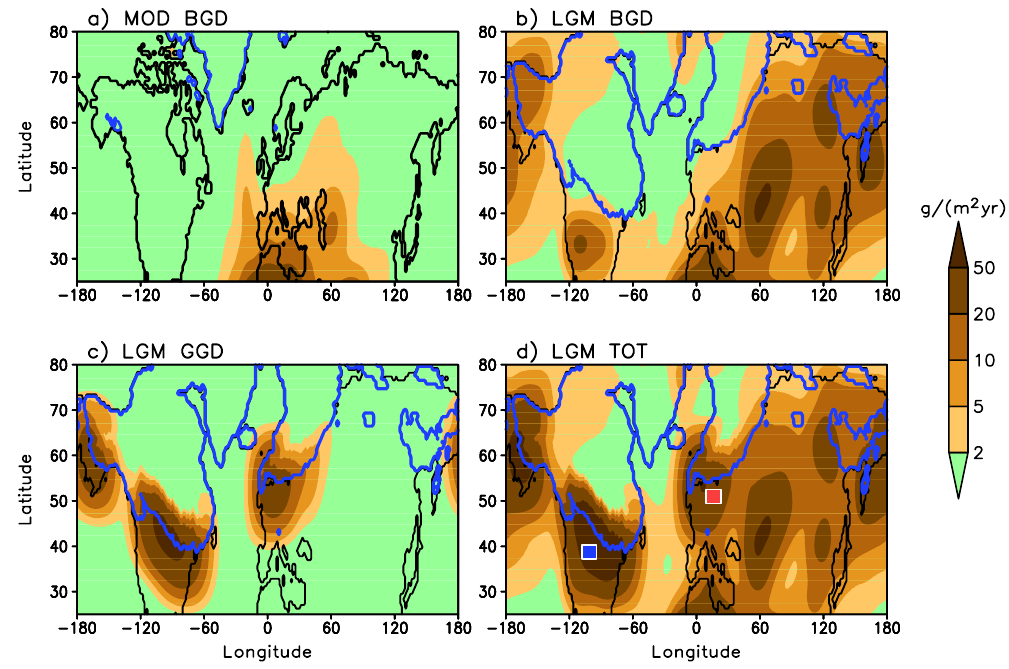
Fig. 9. Annual background dust deposition rates for (a) modern conditions and (b) LGM conditions based on Mahowald et al. (1999). (c) Simulated glaciogenic dust deposition rate at the LGM, and (d) total dust deposition rate at the LGM equal to sum of the fields shown in (b) and